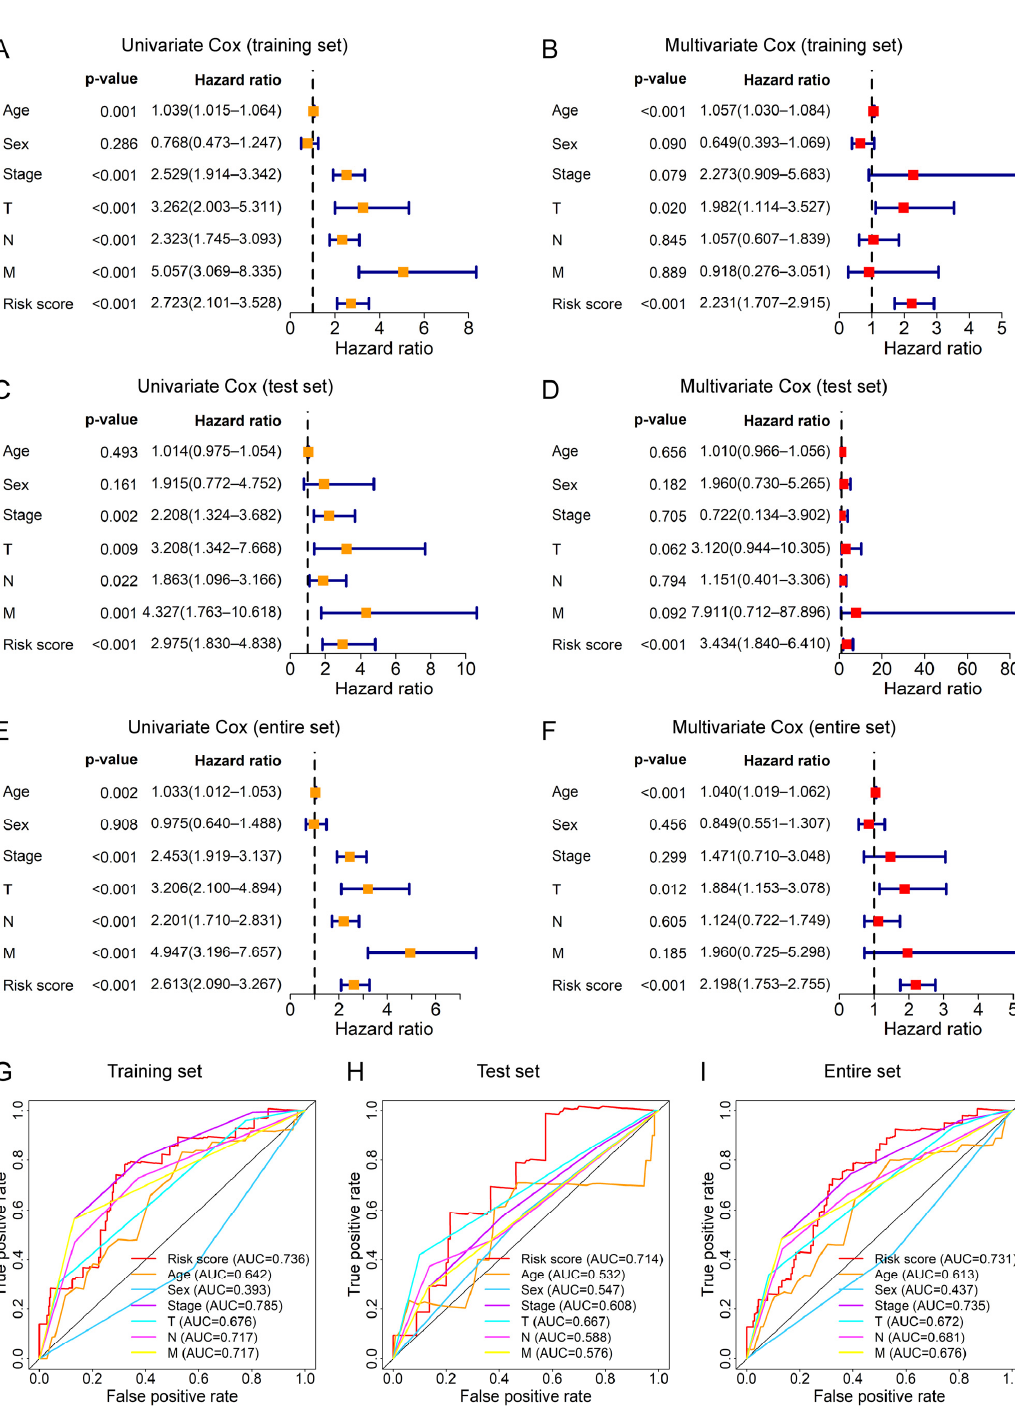
Figure 6. Assessment for the prognostic independence of the risk score. ( A , B ) show the univariate Cox and multivariate Cox analysis of OS based on the risk score and clinical characteristics (age, sex, TNM stage, T stage, N stage, and M stage) in the training set, respectively. ( C , D ) show the univariate Cox and multivariate Cox analysis of OS based on the risk score and clinical characteristics in the test set, respectively. ( E , F ) show the univariate Cox and multivariate Cox analysis of OS based on the risk score and clinical characteristics in the entire set, respectively. The 1-year ROC curves of OS based on the risk score and clinical characteristics in the training set ( G ), test set ( H ), and entire set ( I ) indicate the prognostic accuracy of these variables. Unadjusted hazard ratios represent the 95% confidence